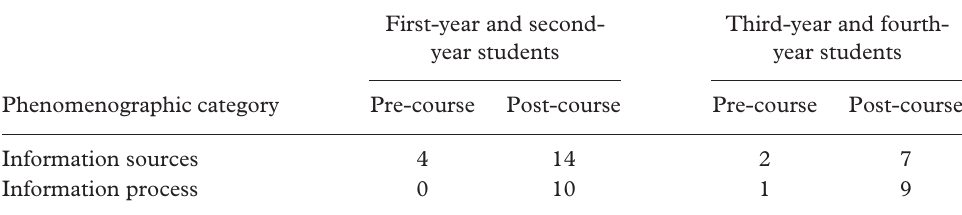
Table 3. The number of student comments indicating an increase in understanding